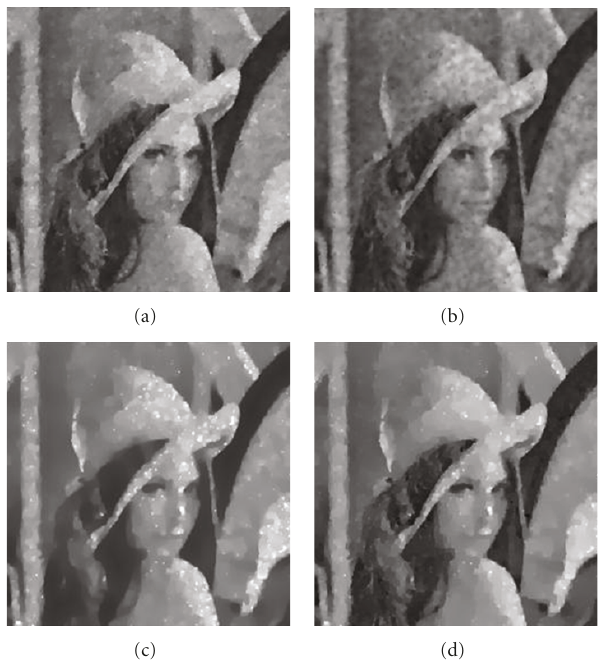
Figure 7: The restored SAR images for denoising of Figure 3(b): (a) by the proposed method ( α 1 = 4 × 2 32 , α 2 = 18 × 2 32 , and ζ = 5 × 10 − 3 ); (b) by the “HMW” method ( α 1 = 0 . 01, α 2 = 0 . 004); (c) by the “AA” method; (d) by the “RLO”